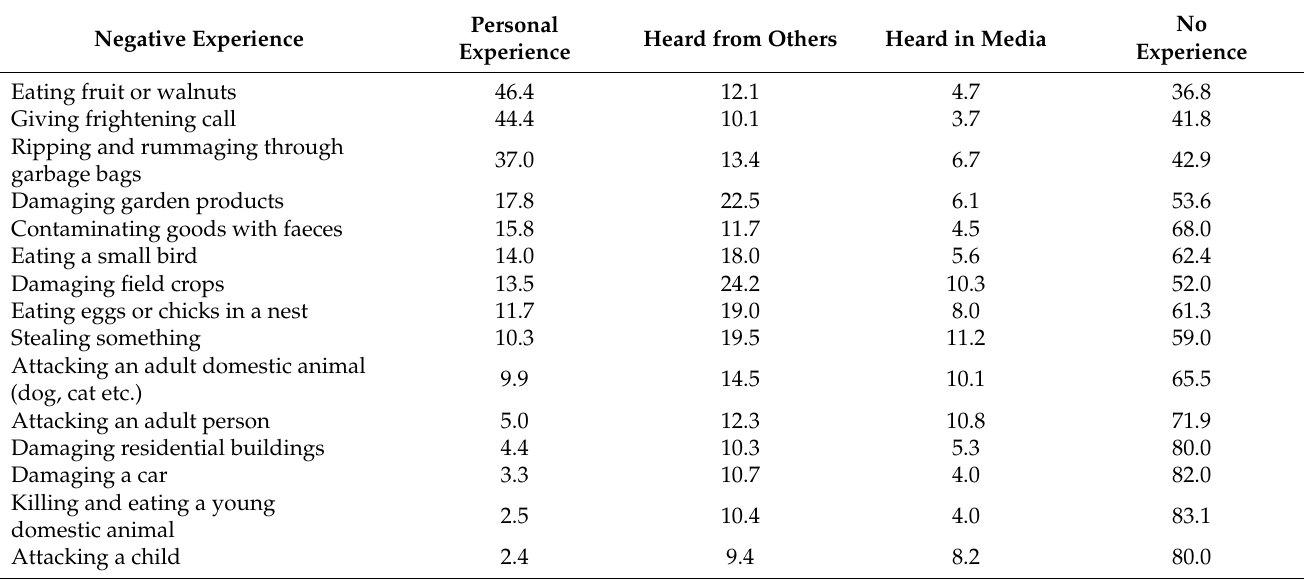
Table 1. Percentage of responses reporting negative experience with hooded crows (listed in decreas- ing frequency of personal